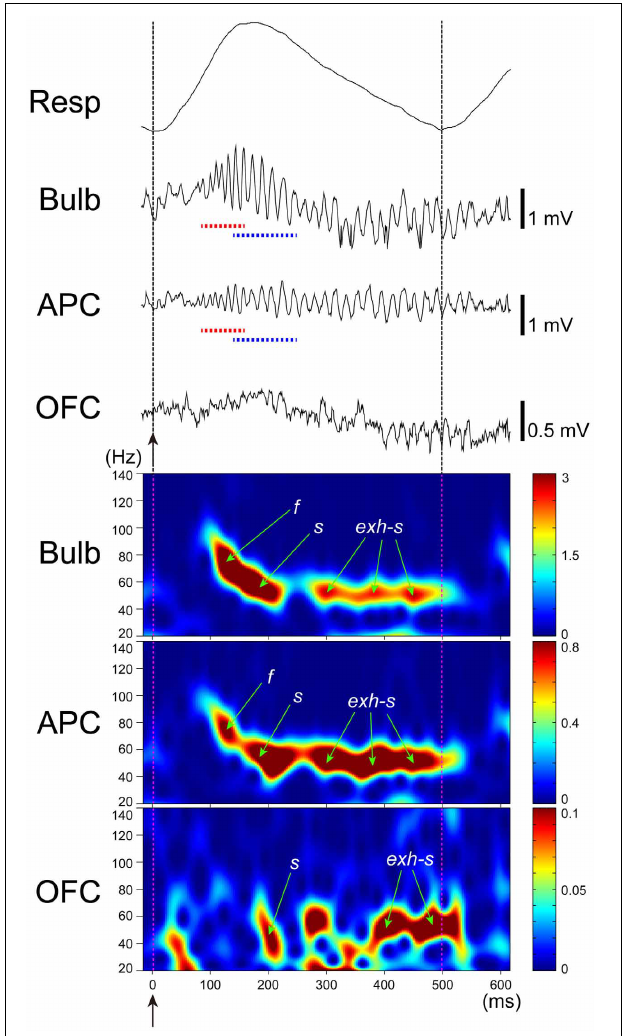
FIGURE 6 | Gamma oscillation couplings across the olfactory bulb, anterior piriform cortex, and orbitofrontal cortex. Simultaneous recordings of respiratory pattern (Resp, upward swing indicates inhalation), LFP in the granule cell layer of the olfactory bulb (Bulb), LFP in layer III of the APC (APC), and LFP in the deep layer of OFC (OFC), during micro-arousal. Wavelet analyses of the LFPs are shown in the lower three figures. Broken lines and upward arrows indicate sniff onset. Early-onset fast gamma oscillation is shown by f or red broken line, and later-onset slow gamma oscillation by s or blue broken line. Slow gamma oscillation during the exhalation period is shown by